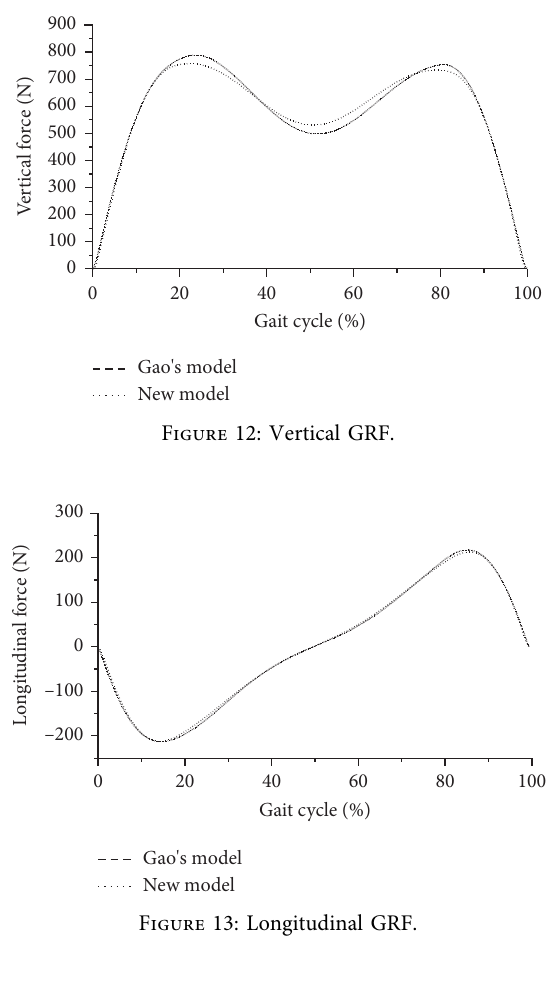
Figure 13: Longitudinal GRF.